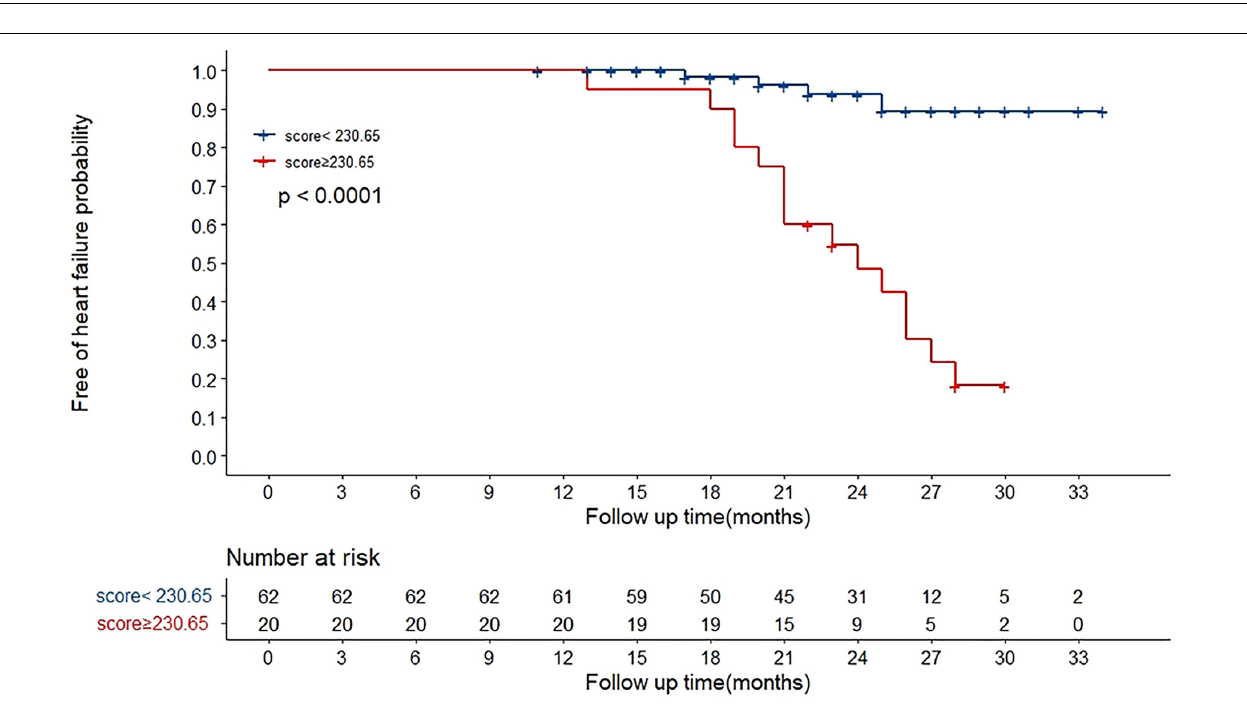
FIGURE 4 | Overall HF occurrence stratified by nomogram in the cohort. The 82 patients were divided into upper and lower groups according to risk scores measured by nomogram (group 1 score: < 230.65, group 2 score: ≥ 230.65). The risk of HF increased along with increasing risk score (log-rank test 28.2, p < 0.001).